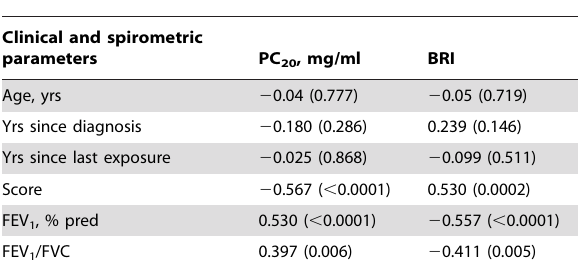
Table 2. Pearson correlation coefficients between the airway responsiveness indices and clinical and spirometric parameters [r (P